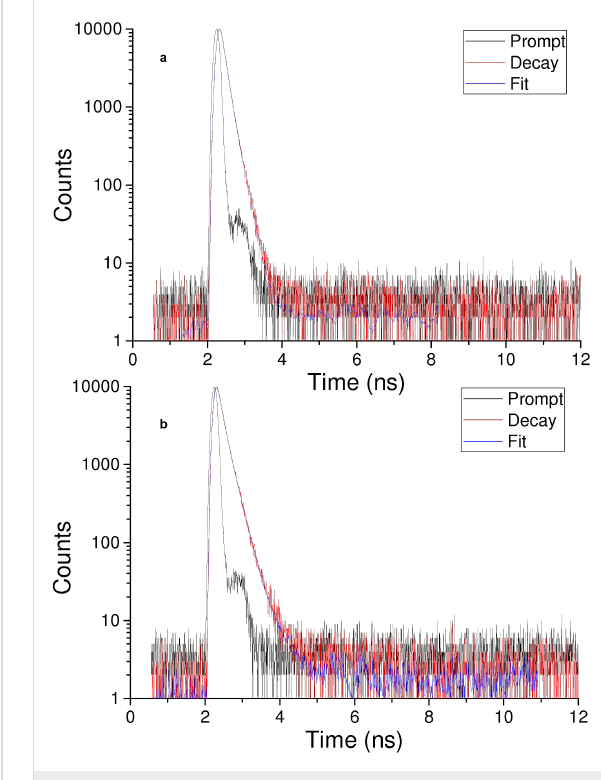
Figure 7: Time-resolved fluorescence observed for aqueous solutions of (a) eosin Y ( 2 ) and (b) the 2 – β -CD conjugate. λ exc = 455 nm; λ em = 570 nm.